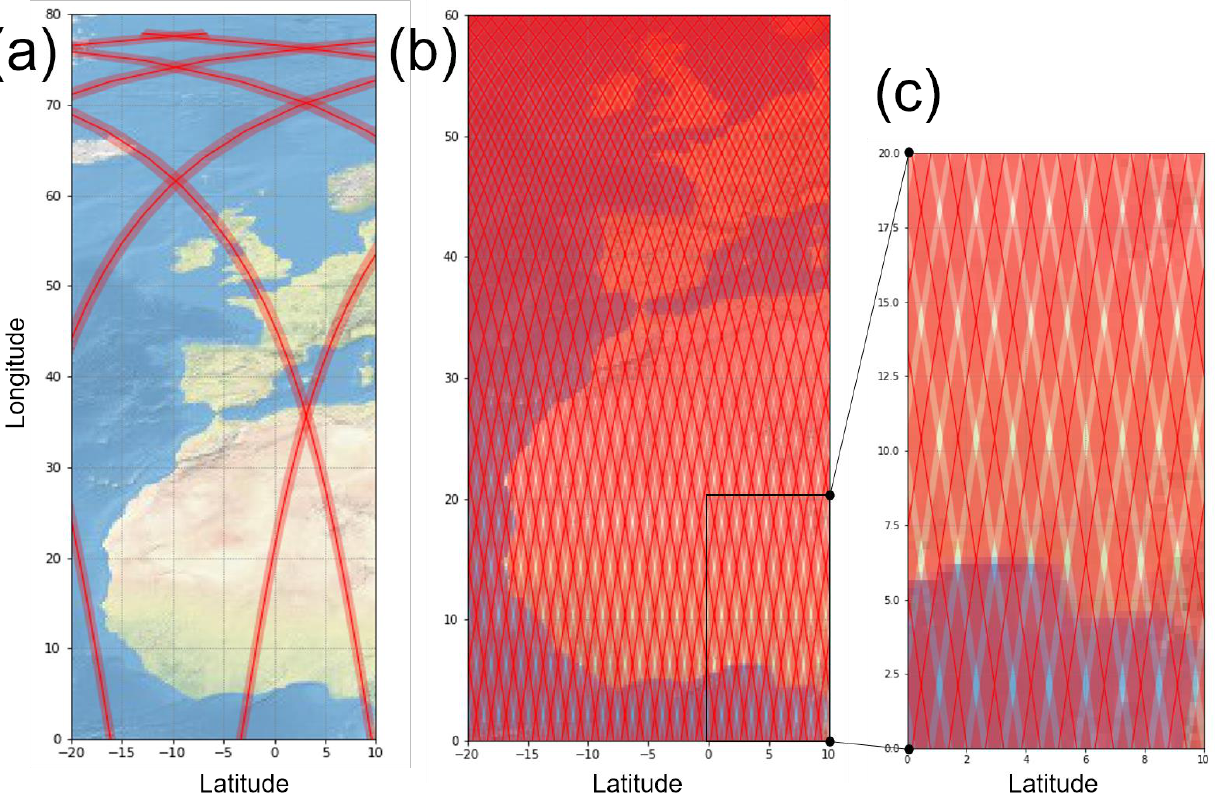
Figure 4. Coverage of KaRIn products (red area, semi-transparent) and the nadir altimeter (red line). Panel ( a ) is the one-day or Cal/Val orbit. Panel ( b ) is the 21-day or science orbit. Panel ( c ) is a zoom of panel ( b ) at low latitudes: it emphasizes the rare regions that are not observed by KaRIn and the near ubiquity of crossover diamonds (darker red).